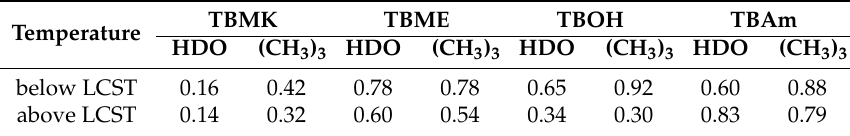
Table 1. T 2im parameters for the PVME/additive solutions ( c P = 5 wt %, c ad = 5 wt %).